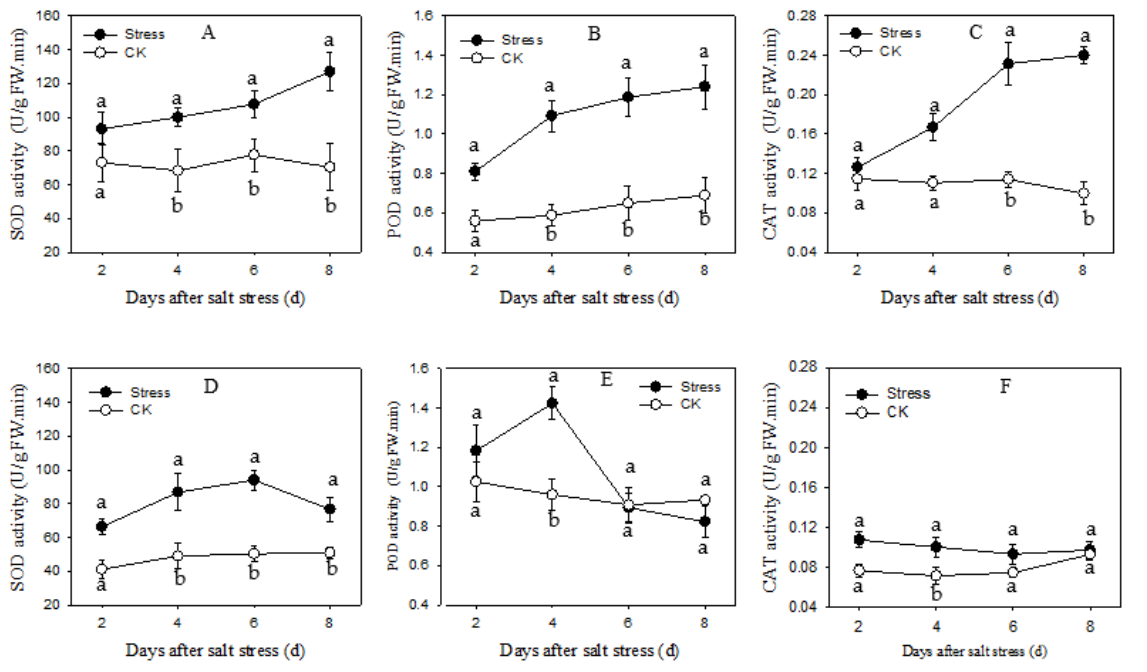
Figure 3. The SOD, POD, CAT enzyme activities of two asparagus cultivars under salt stress. ( A – C ) are Apollo and ( D – F ) are JL 1. Different lowercase lettersin the line graph indicate significantly different from the control at p < 0.05. CK meaning seedlings were watered by Hoagland solution without NaCl, and SS meaning seedlings were subjected to salt stress of 120 mM NaCl.